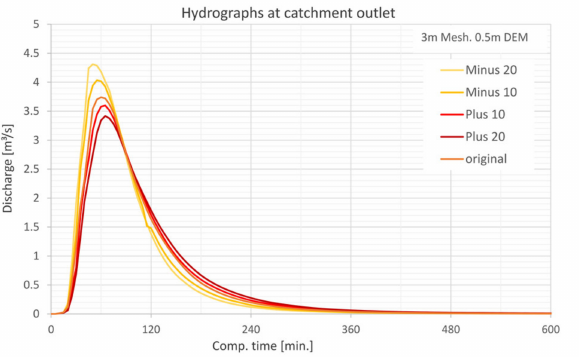
Figure 27. Qualitative comparison of the hydrographs and model sensitivity for Manning’s n values at the catchment outlet for 3 m mesh and 0.5 m DEM.